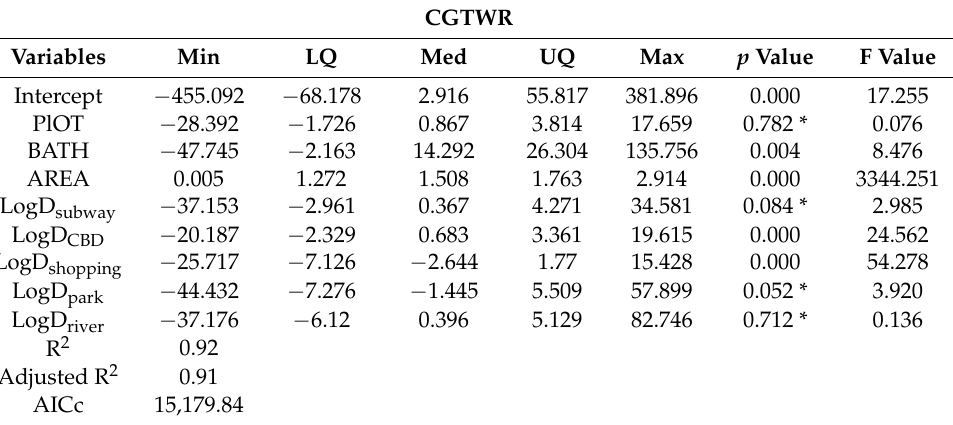
Table 7. The distribution of the localized coefficient estimates for the CGTWR model (B = 2221, τ = 80,118, and ς =